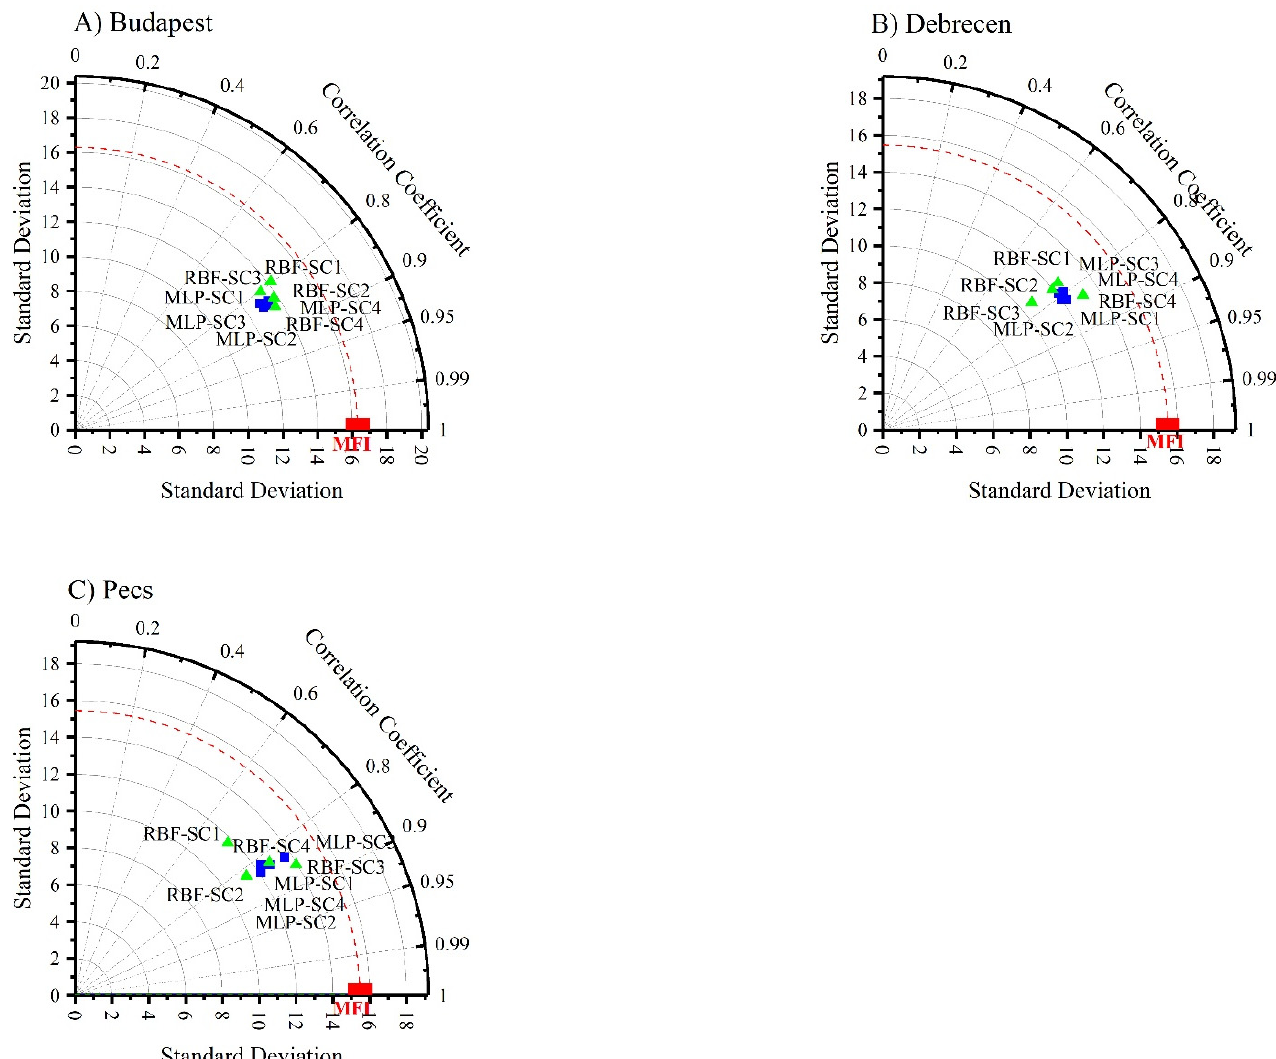
Figure 9. Analysis of ANN–MLP and ANN–MLP RBF performance in predicting MFI using a Taylor diagram. ( A ) Budapest. ( B ) Debrecen. ( C ) Pecs.